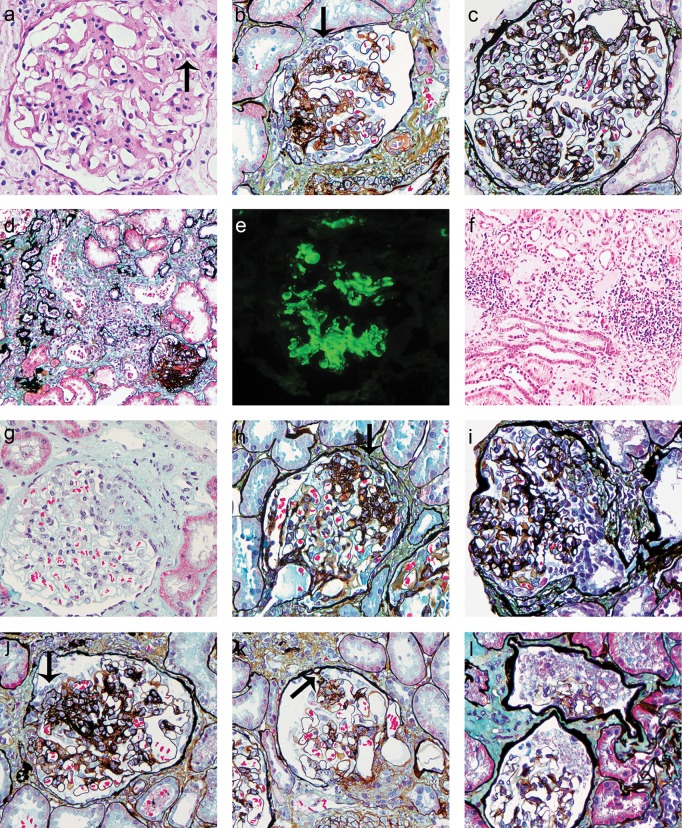
FSGS lesions in IgA nephropathy.(a) Oxford criterion—mesangial hypercellularity. Multiple mesangial areas show more than four mesangial cells. Capsular adhesions are also observed (arrow). Periodic acid-schiff (PAS), original magnification × 400. (b) Oxford criterion—segmental glomerulosclerosis. The segmental scar shows significant epithelial proliferation and capsular adhesion (arrow), thus it also defined as a type of FSGS lesion. Periodic acid-silver methenamine (PASM), original magnification × 400. (c) Oxford criterion—endocapillary hypercellularity. Many of the lobules show endothelial cell proliferation in the capillary lumens. PASM, original magnification × 400. (d) Oxford criterion—tubular atrophy/interstitial fibrosis. They accompany the serious sclerotic lesions of a glomerulus. PASM, original magnification × 200. (e) Immunofluorescence for IgA. Segmental IgA-dominant deposition within the glomerular mesangium. original magnification × 400. (f) Interstitial infiltration. Local significant interstitial inflammatory cell infiltration. Hematoxylin and eosin (HE), original magnification × 200. (g) Perihilar variant of an FSGS lesion. Sclerosis appears at the vascular pole. Perihilar sclerosis and/or hyalinosis were identified in more than 50% of the glomeruli with segmental lesions. Masson trichrome, original magnification × 400. (h) Tip lesion. Segmental sclerosis lesions appear at the tubular pole with adhesions of epithelial cells with parietal cells at the tubular neck (arrow). PASM, original magnification × 400. (i) Cellular lesions of FSGS. Segmental endocapillary hypercellularity with significant epithelial hyperplasia. PASM, original magnification × 400. (j) Not otherwise specified (NOS) FSGS lesions. Segmental scar with capsular adhesion and hyperplasia of epithelium (arrow). PASM, original magnification × 400. (k) Capsular adhesion. The glomerulus presents adherence to the capsule (arrow) with an epithelial cell proliferation reaction, consistent with the NOS variant of FSGS. PASM, original magnification × 400. (l) Pseudocrescent in Bowman’s space. Proliferous epithelial cells fill most of the capsule space, without blocking it. PASM, original magnification × 400.